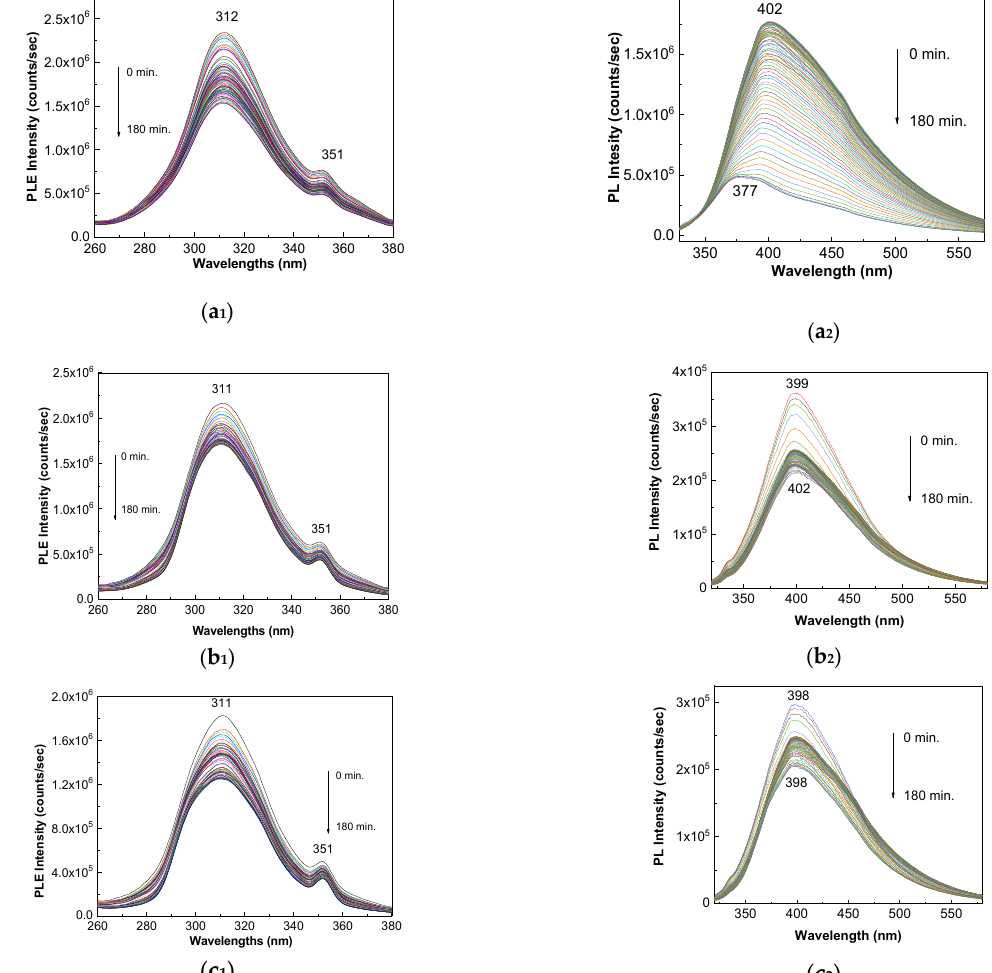
Figure 8. PLE and PL spectra of NaOH ‐ reacted LO, the volumetric ratio of the LO and NaOH is equal to 2:1 ( a 1 , a 2 ), 1.5:1.5 ( b 1 , b 2 ) and 1:2 ( c 1 , c 2 ) and their evolution when the samples are exposed to UV light. The reaction of LO with NaOH leads: